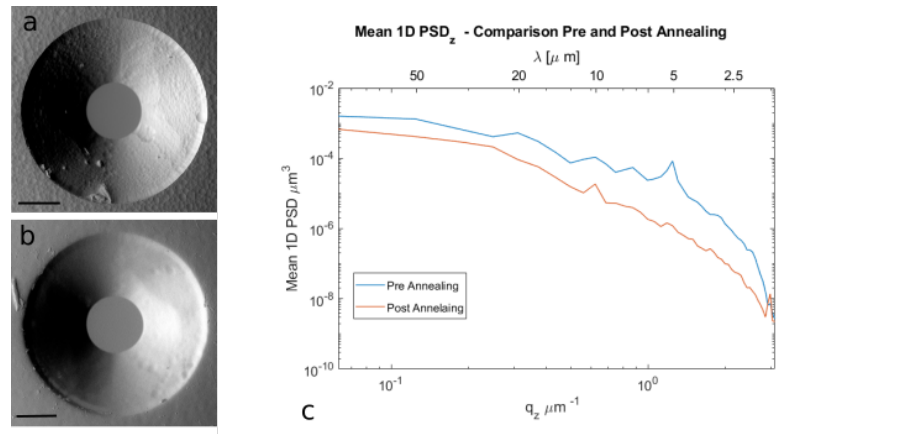
Figure 2. Thermal annealing effect on surface roughness. SEM images of two microstructured cones before ( a ) and after ( b ) thermal treatment. Scale bars correspond to 50 µ m; ( c ) comparison of sample C 1D PSD z before and after the thermal treatment, reported in logaritmic scale.